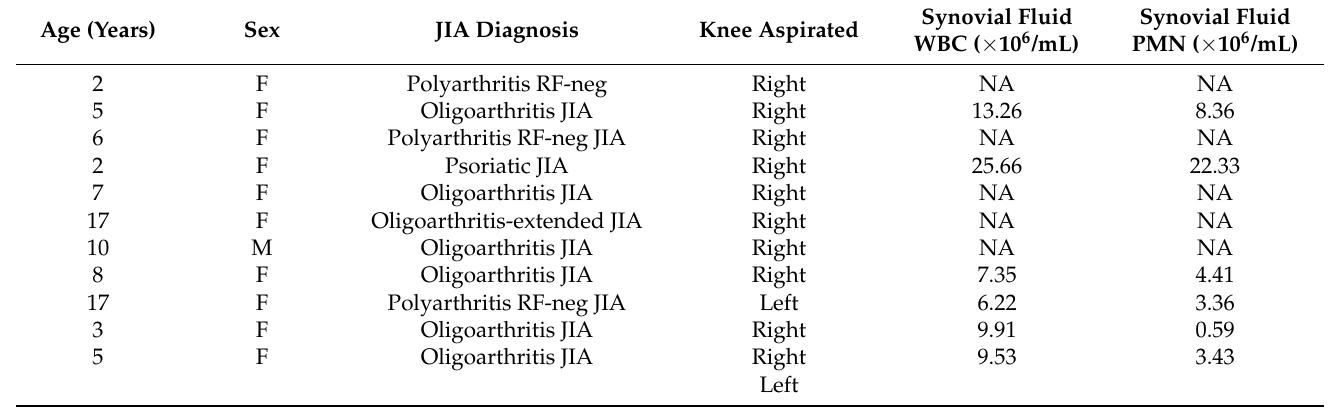
Table 1. Patient demographic